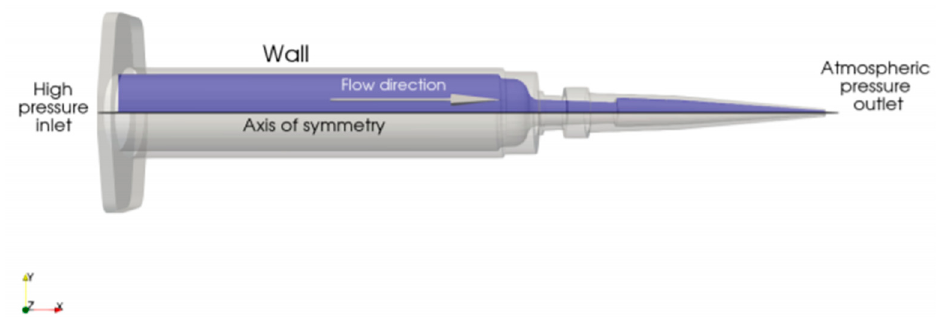
Figure 2. Schematic depiction of the computational domain.